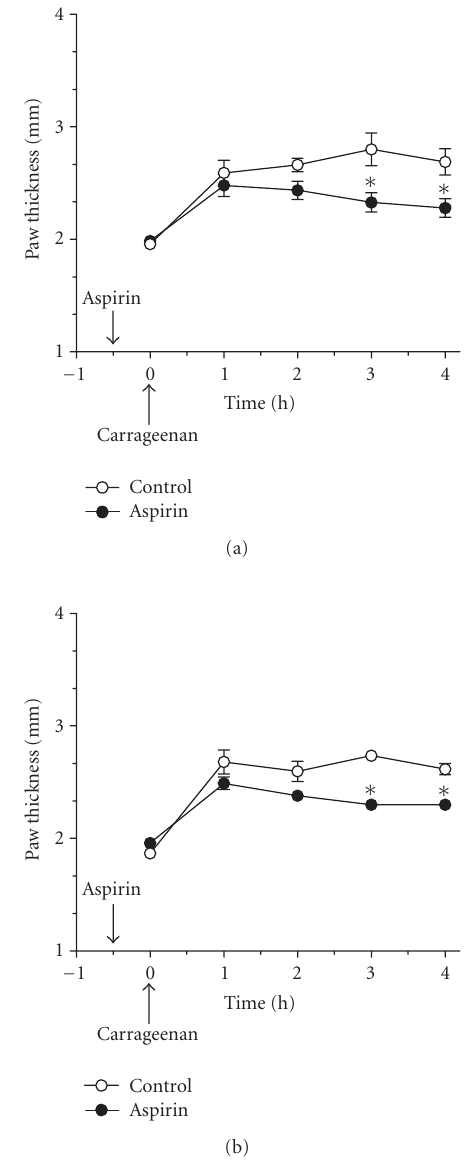
Figure 4: E ff ect of the PPAR γ agonist L-805645 on the profile of carrageenan-induced paw edema in wild-type and hepatocyte-specific RXR α -deficient mice. Wild-type (a) and hepatocyte-specific RXR α - deficient mice (b) were treated intraperitoneally with (100 mg/kg) of L-805645, 30 minutes before induction of inflammation. As in- dicated by the arrow, carrageenan (1%, intraplantar) was injected at t = 0. Carrageenan-induced edema is reflected by an increase in paw thickness. Values represent mean ± SEM. n = 4–6 mice per group. ∗ P < . 05 versus corresponding wild-type point.